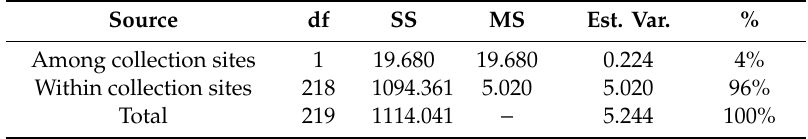
Table 3. Analysis of molecular variance (AMOVA) of 110 P. koraiensis clones grown at the Naozhi seed